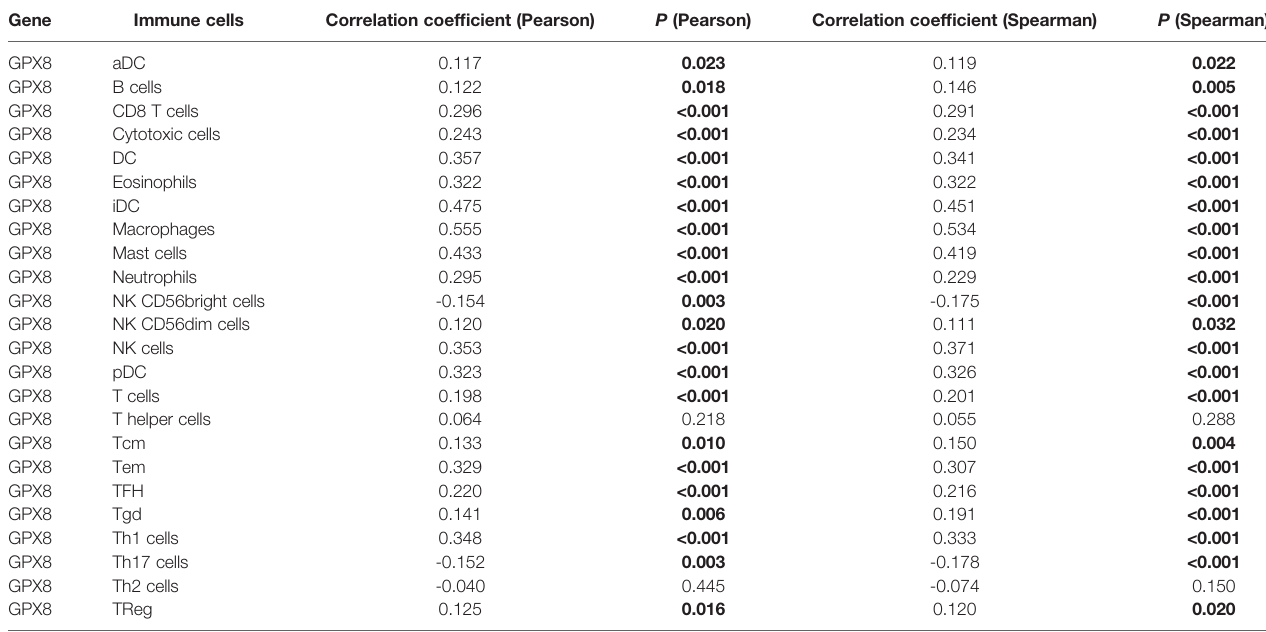
TABLE 2 | Correlation between GPX8 expression and immune cell in fi